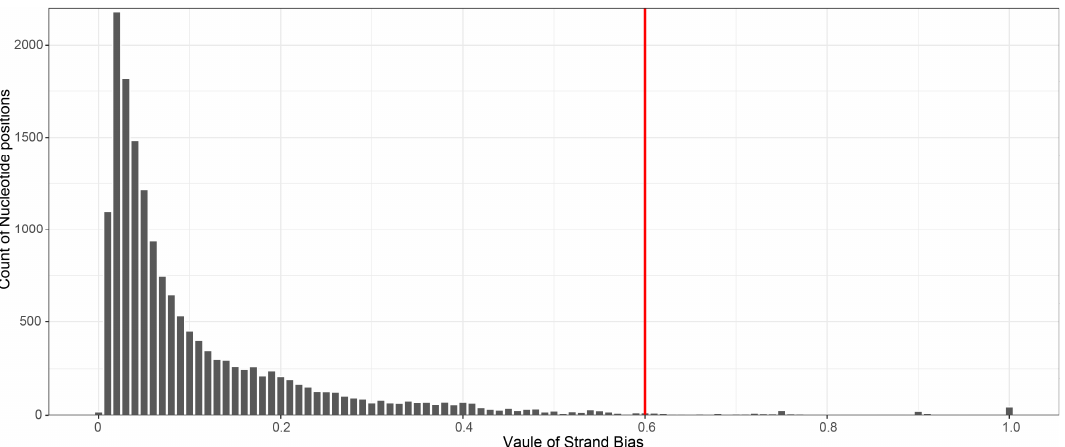
Figure 3. Overall strand bias distribution in the 60 detected sample libraries. A value of 0 indicates no strand bias, and 1.0 indicates the presence of reads in only 1 direction. Data from the 4 controls were not included, resulting in a total of 60 calculated datasets.